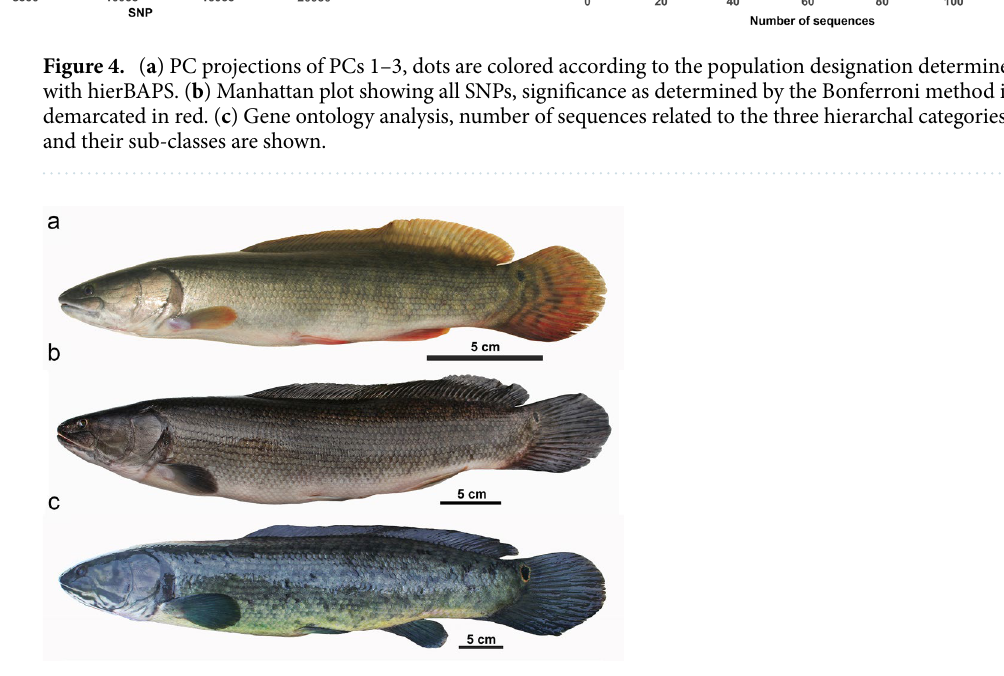
Figure 5. ( a ) Amia calva from the lower Savannah River, SC, showing live colors. ( b ) Freshly preserved A. calva from Schultz Lake, SC, which drains into the south side of Charleston Harbor (the reported type locality of A. calva ). ( c ) Putative specimen of A. ocellicauda (potential neotype; Royal Ontario Museum 99787) from Georgian Bay, ON, showing contrasting color pattern to ( a ) and ( b ); photos by